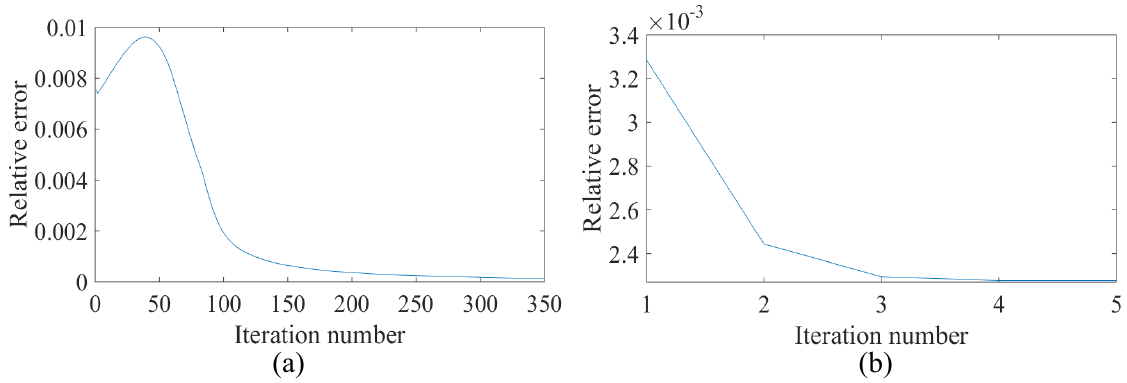
Figure 12. Curves of relative error values versus: ( a ) inner iterations; ( b ) outer